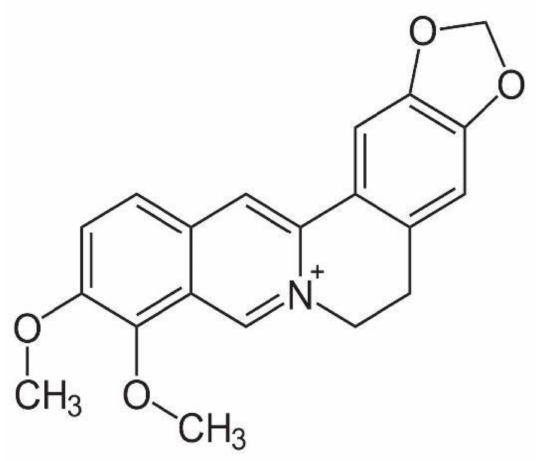
Figure 4. Chemical structure of